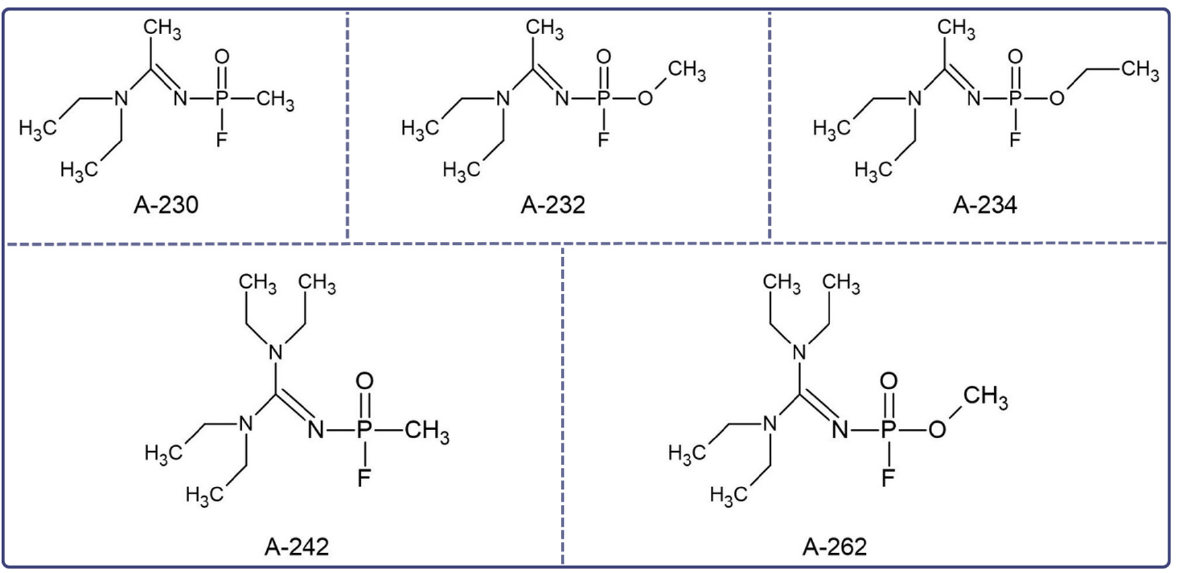
Figure 1. Novichoks’ structures developed at the State Scientific Research Institute for Organic Chemistry and Technology (GOSNIIOKhT) and revealed by Mirzayanov [2].